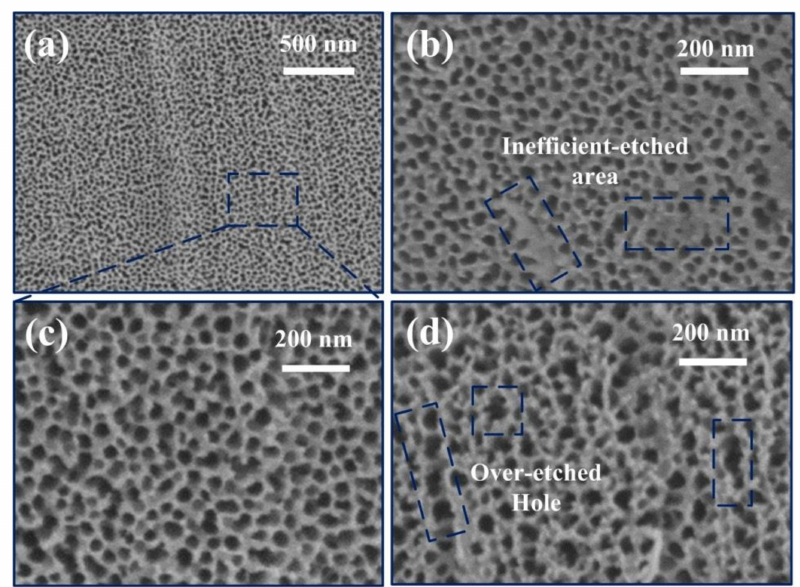
Figure 1. SEM graphs of NASS samples with different anodic oxidation potential. ( a ) The overview graph of NASS sample with applied potential of 50 V. ( b – d ) The high magnification graph of NASS sample with applied potential of ( b ) 30 V, ( c ) 50 V and ( d ) 70